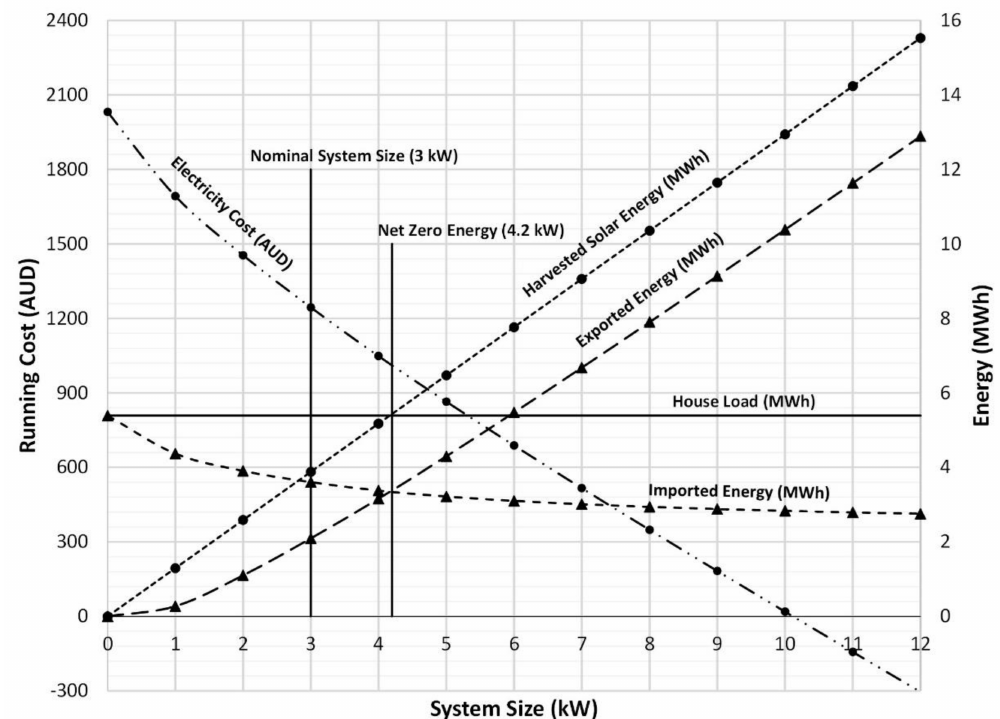
Figure 3. House 1: Energy flows and cost of electricity as a function of PV system